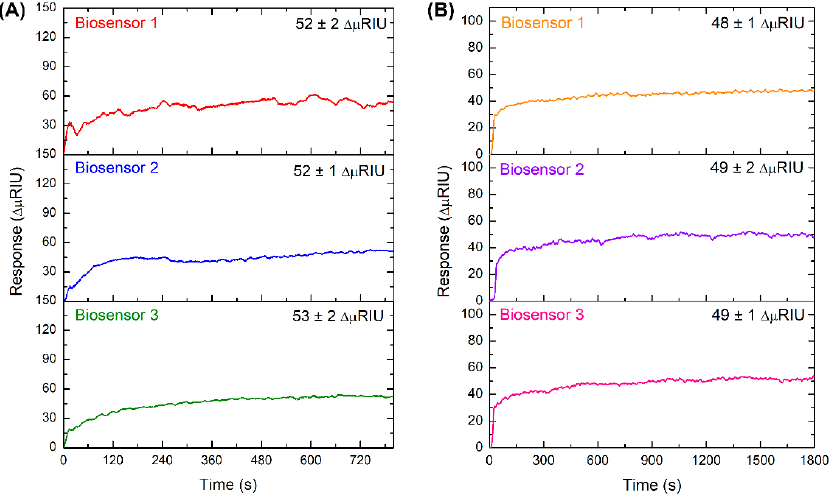
Figure 6. Detection responses of MT-C ( A ) and NT-C ( B ) strands at 10 nM on the three biosensors